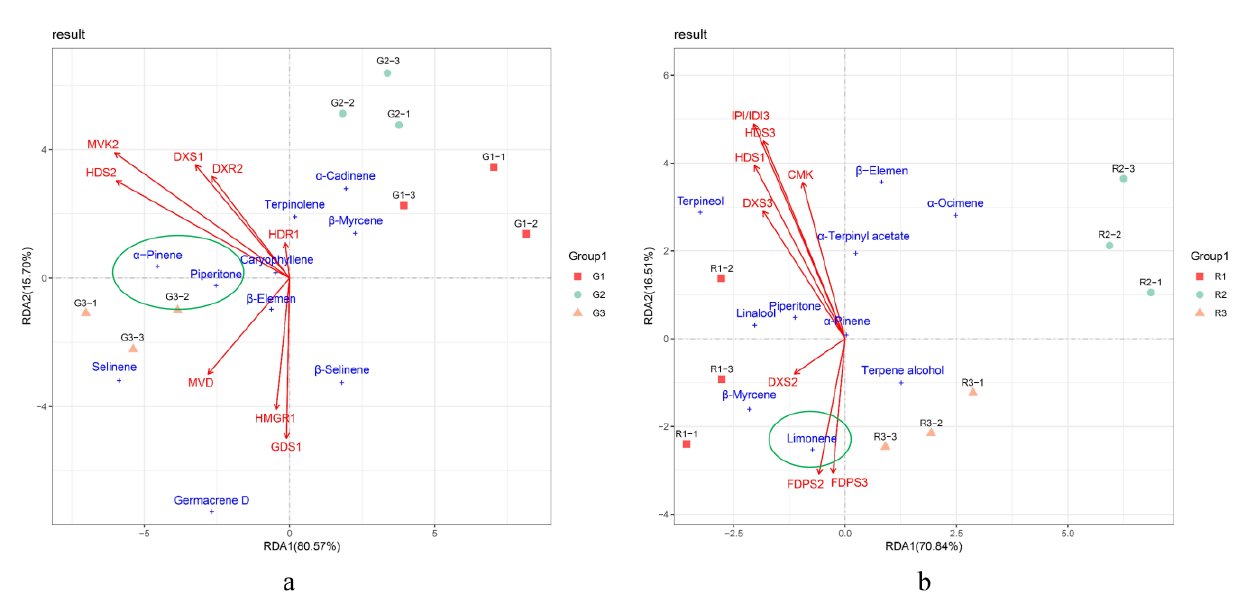
Figure 7. Redundancy analysis (RDA) of terpenoids and terpenoid synthesis genes in prickly ash fruit. ( a ) RDA analysis of terpenoids and terpenoid synthesis genes at different developmental stages of green prickly ash. ( b ) RDA analysis of terpenoids and terpenoid synthesis genes at different developmental stages of red prickly ash.